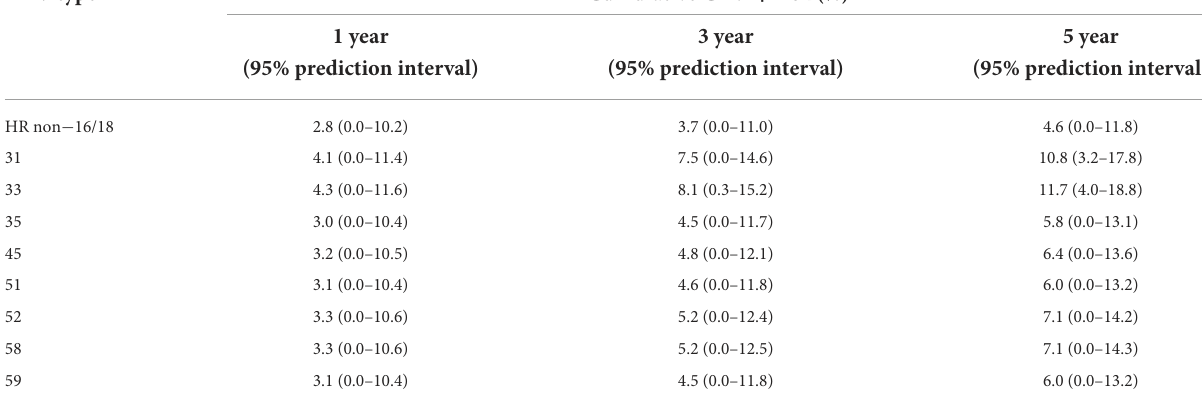
TABLE 3 The progression rates by time for the most frequent non-16/18 HR-HPV